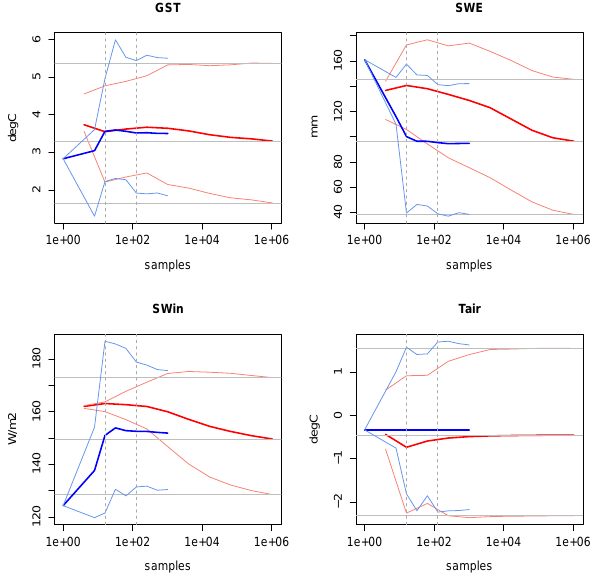
Fig. 7. Aggregated statistics: mean (bold), 25th and 75th percentile (non-bold) of the sub-grid scheme at resolutions 1–1024 samples (blue) and distributed simulations (red) spanning resolutions of 4– 10 6 pixels. Vertical lines indicate 16 and 128 samples. A stable per- formance is reached after the 128 sample level in all cases. Topo- SUB is able to approximate aggregated 2-D simulation at 10 4 less computations. Note logarithmic X-scale.